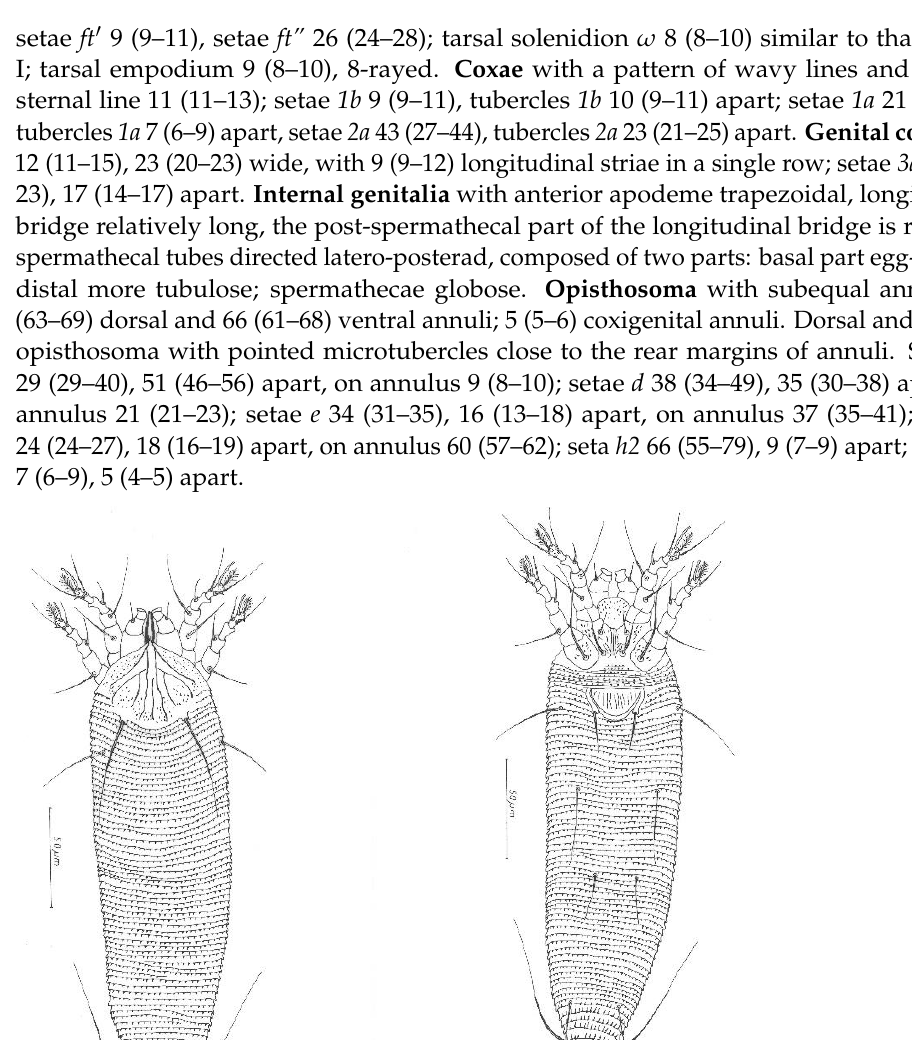
Type material. Female holotype (slides # 862/1) and paratypes 42 females, 4